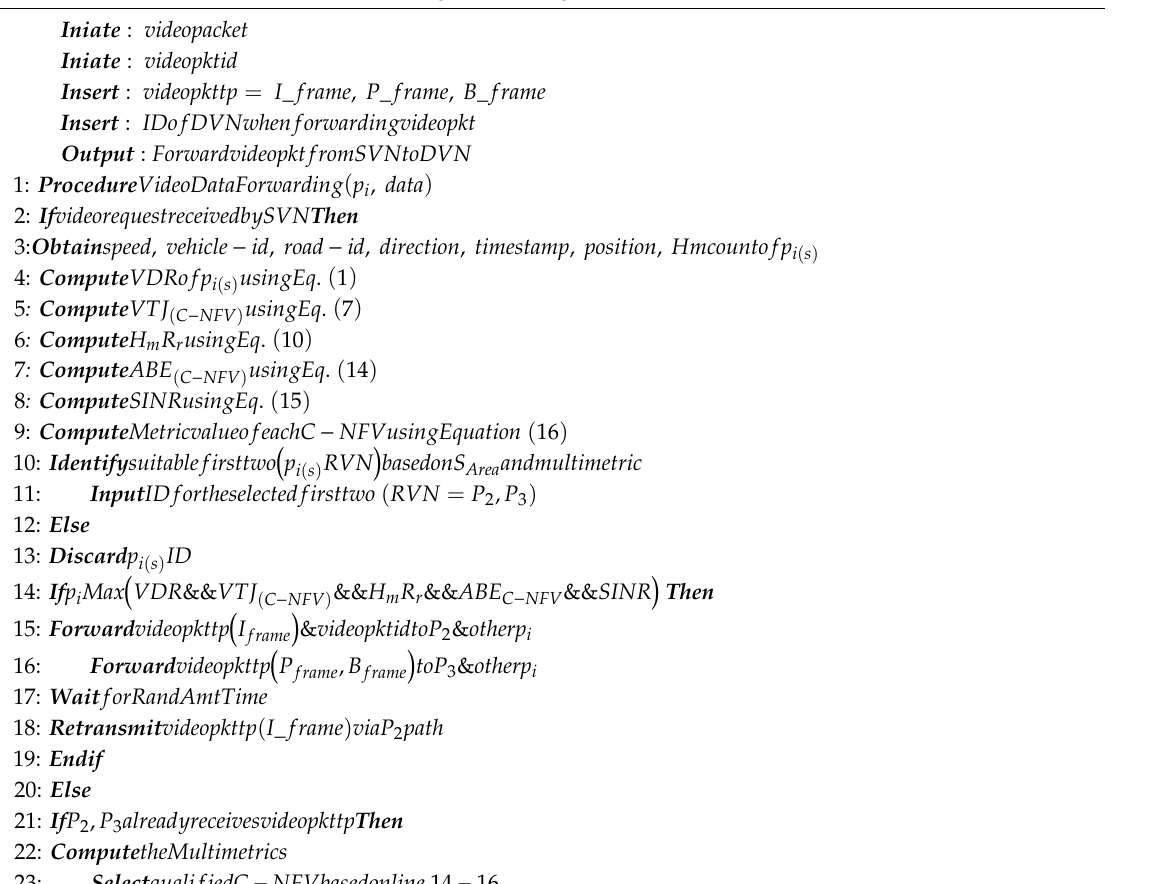
Algorithm 1. Multi-metric Video Streaming